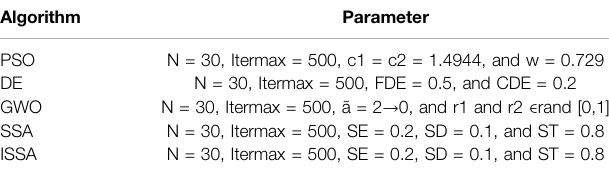
TABLE 2 | Parameter settings of the optimization algorithms. Algorithm Parameter PSO